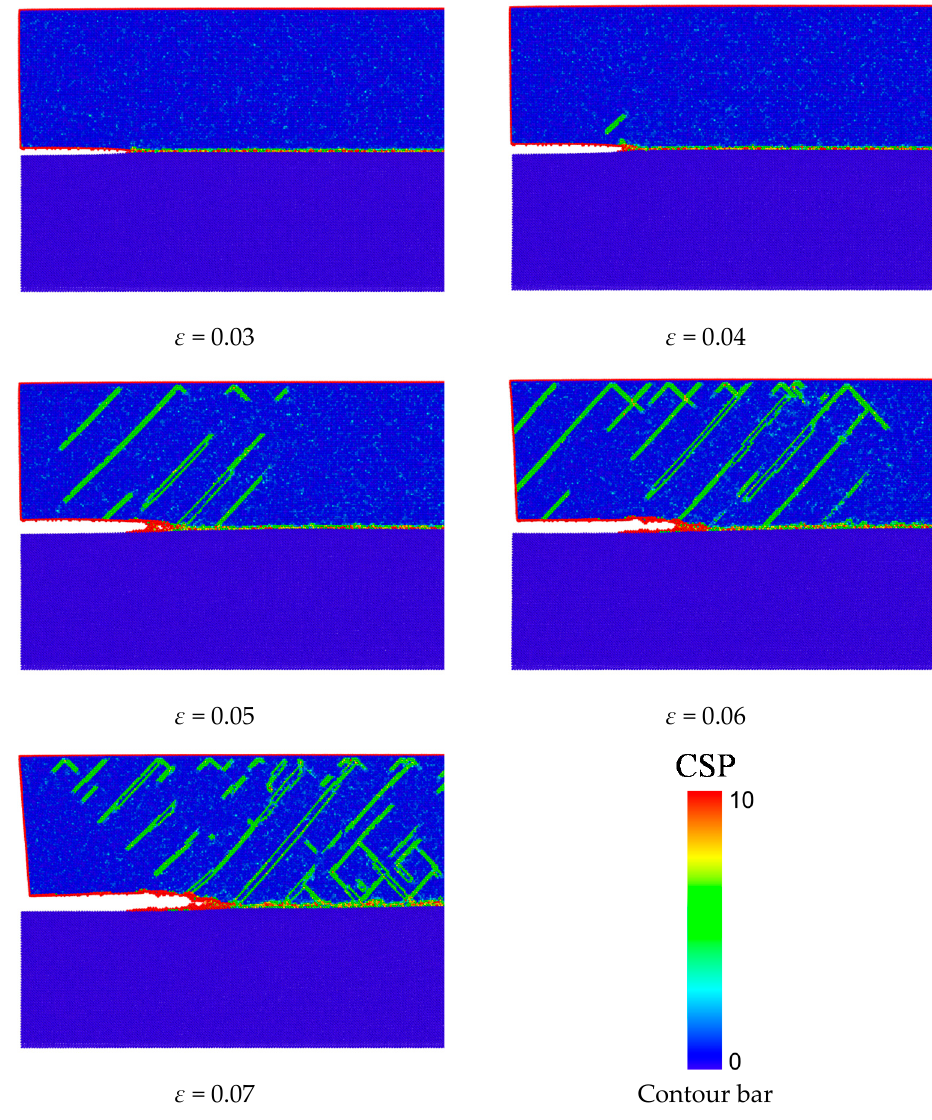
Figure 10. Contour diagram of the CSP in Model 1.